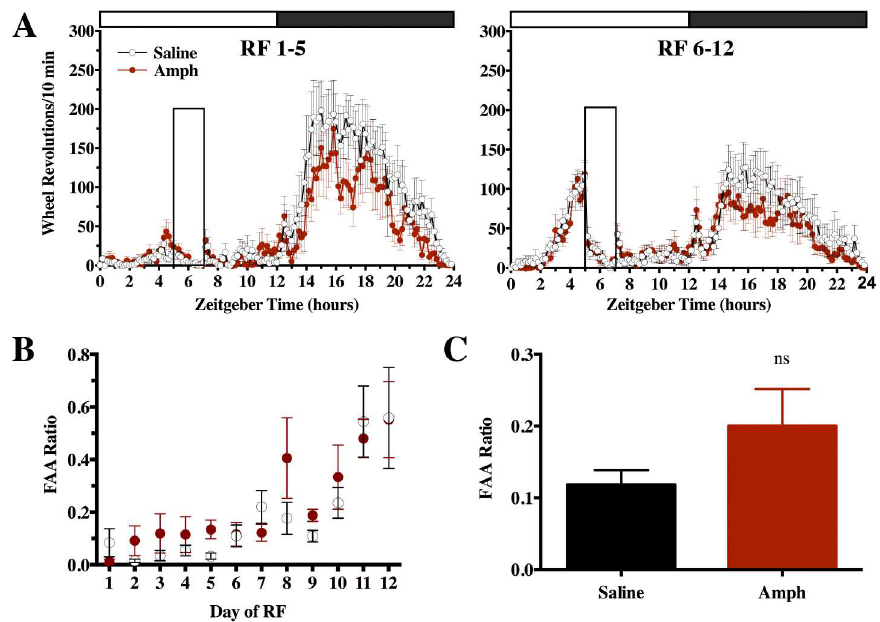
Fig 4. Exp 1: measuring FAA to RF in rats previously exposed to AMPH or saline injections, between group design. Home-cageactivity expressedin wheel revolutions /10 min +/- SEM for AMPH and saline pretreatedrats, duringRF days 1–5 and 6–12, closed box indicatesfeedingwindow( A ). FAA ratios +/- SEM shown as group averages for each day of RF ( B ) and for the total 12 days of RF ( C ), not significant, ns .